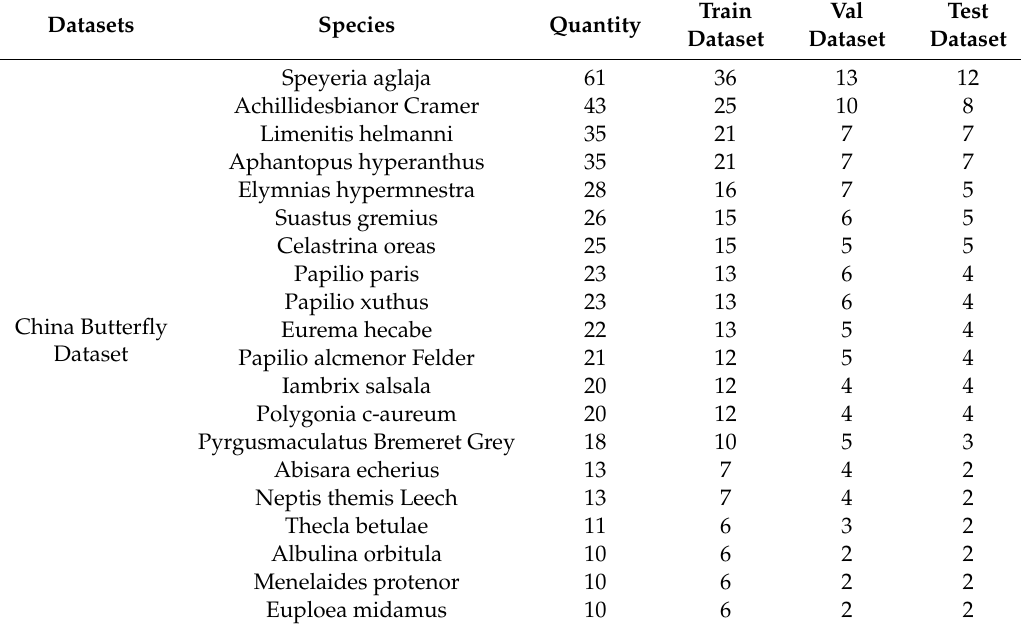
Table 1. The scientific names of butterfly species and distribution of